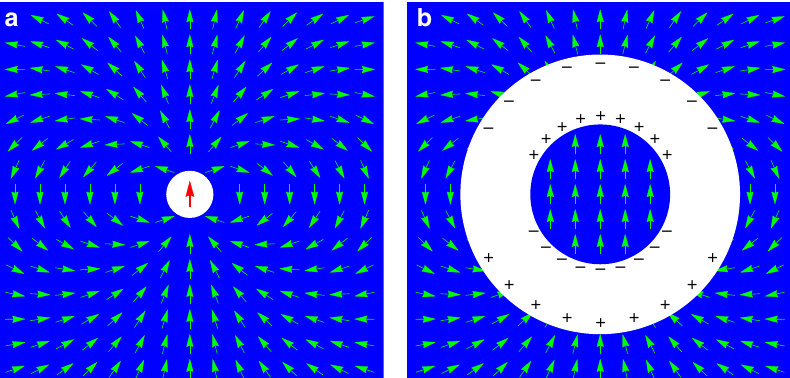
Fig. 1 Onsager ’ s model of a polar liquid. a The model consists of a spherical cavity of molecular dimensions (white) in a continuous polarisable medium (blue). An orientable dipole (red) located at the centre of the cavity polarises the medium (green) through its dipole fi eld. An applied fi eld (not shown) may also be present. The nontrivial properties of the model arise from the solution of the Laplace equation in this context and the corresponding statistical mechanics 2 . b A blow-up of the cavity to illustrate how the central dipole may be replaced by a uniformly polarised sphere with a variable radius. Surface charges on the sphere and cavity walls are